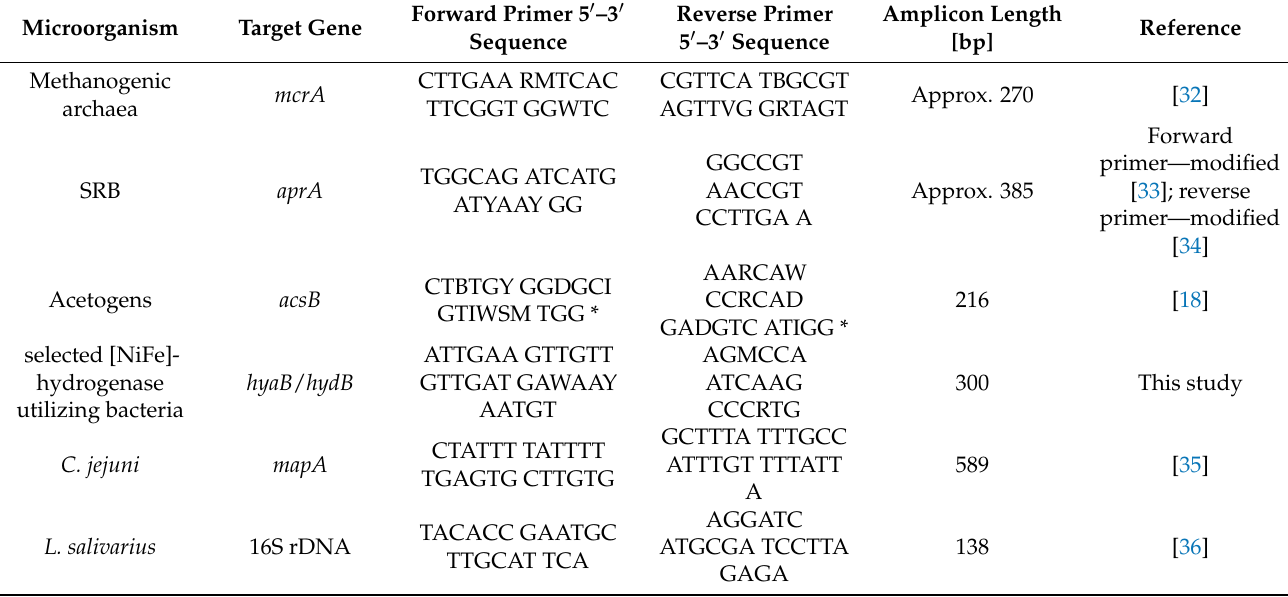
Table 6. Primers used in this